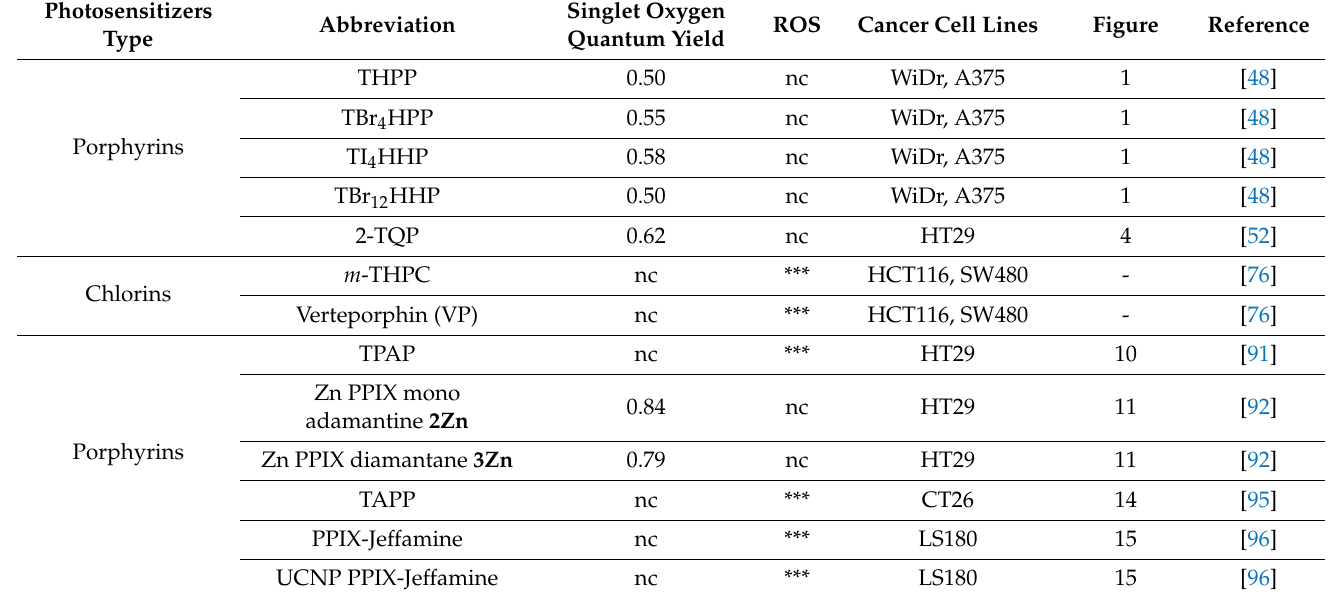
Table 1. Photosensitizers used in the treatment of colorectal cancer